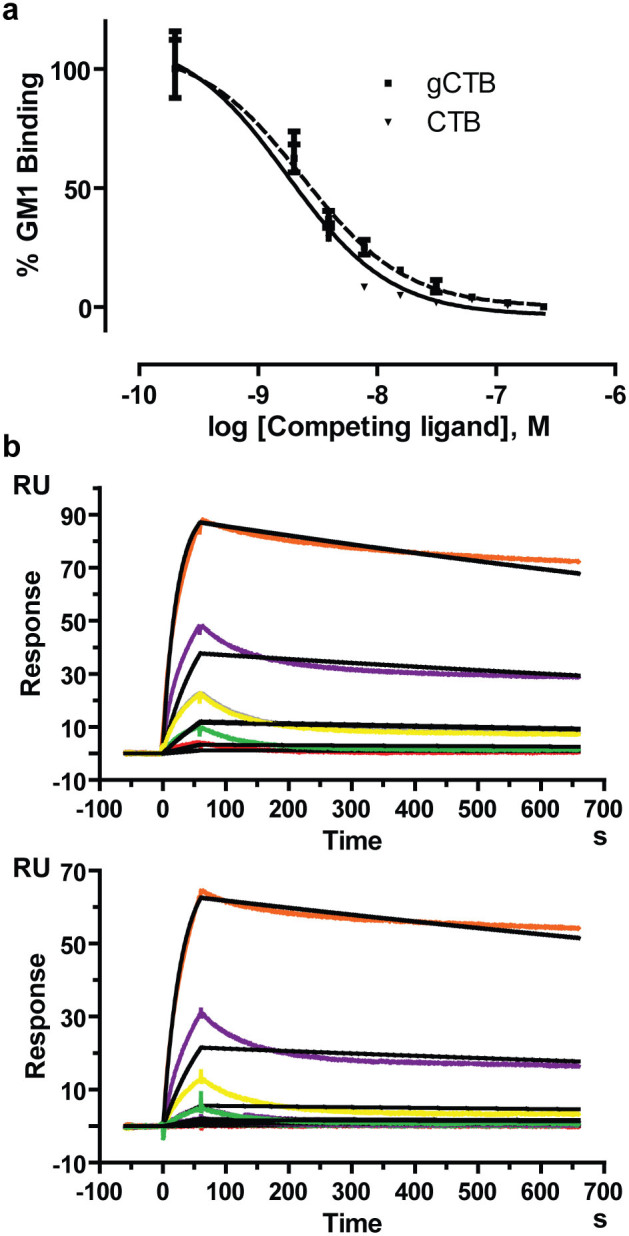
GM1-ganglioside-binding activity of gCTB.(a) Binding affinity determination based on competitive GM1-ELISA. The assay was performed in triplicate. The 50% inhibitory concentrations (IC50) of native CTB and gCTB were determined to be 1.8 and 2.4 nM, respectively. (b) Surface Plasmon Resonance. Each CTB protein was immobilized on a sensor chip, and GM1-ganglioside was used as the analyte. Representative sensorgrams obtained with gCTB (Top) and native CTB (Bottom) are shown. The capture level of gCTB was 210 RU and of native CTB was 175 RU. The colored curves represent various concentrations of GM1-ganglioside (10, 3.33, 1.11, 0.37, and 0.123 μg/ml from top to bottom), and the black lines are the 1:1 binding kinetics fit. The KD values for gCTB and CTB were determined to be 60.1 ± 1.7 and 51.4 ± 5.7 nM, respectively (means ± SD of triplicate).